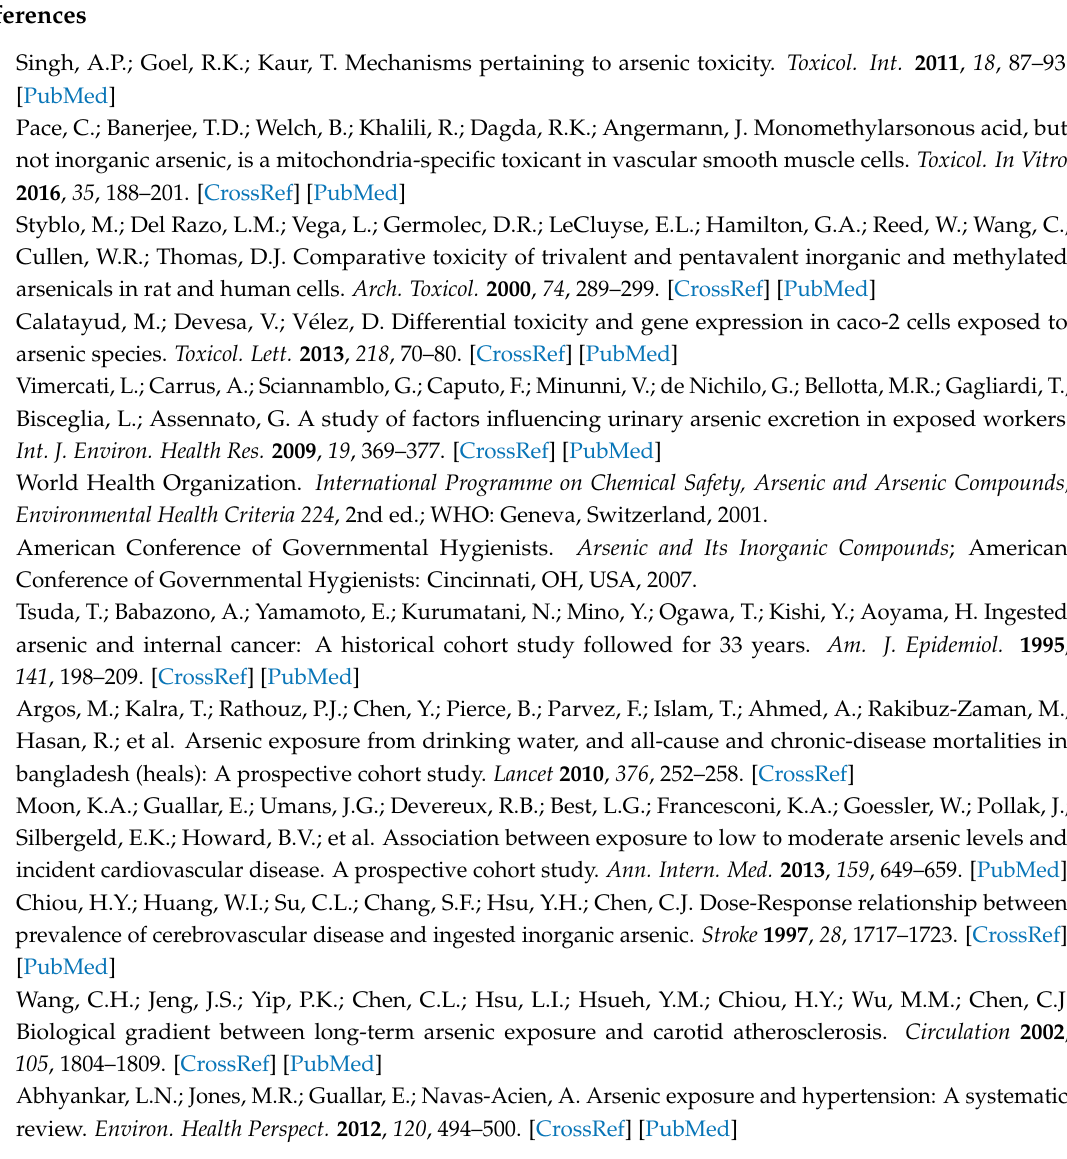
Table S1: Subgroup and sensitivity analyses in fully adjusted, binary logistic regression models with independent variable %MMA in women, Table S2: Subgroup and sensitivity analyses in fully adjusted, binary logistic regression models with independent variable SMI, Table S3: Subgroup and sensitivity analyses in fully adjusted, binary logistic regression models with independent variable %MMA in men, Table S4: Subgroup and sensitivity analyses in fully adjusted, binary logistic regression models with independent variable